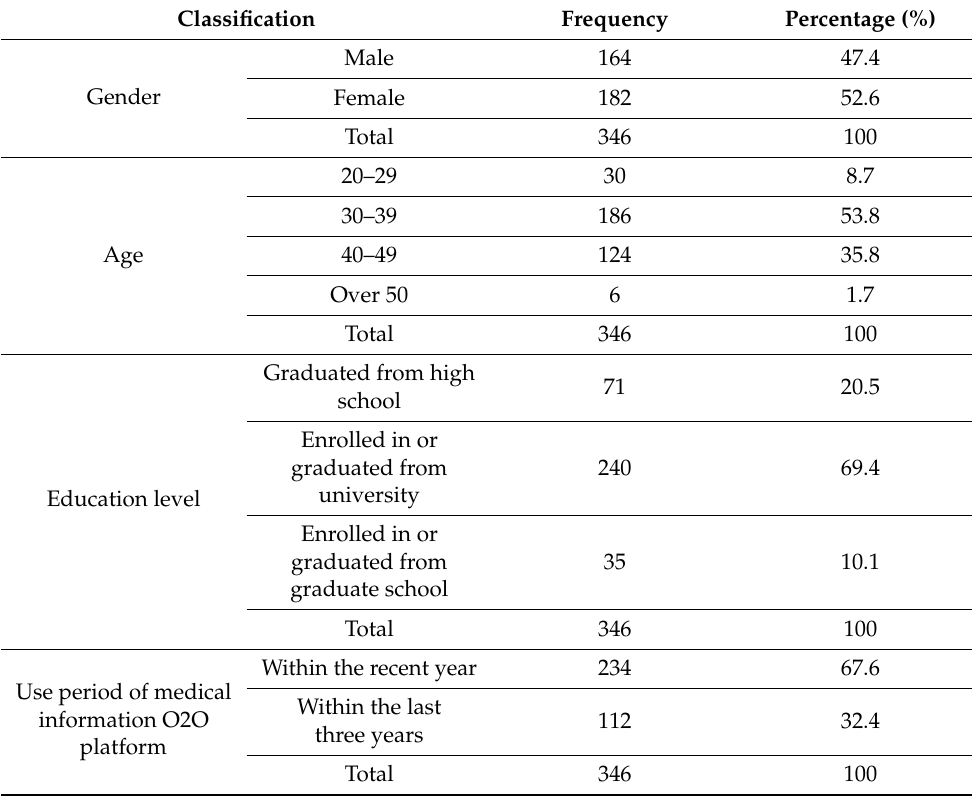
Table 3. Demographic information of survey